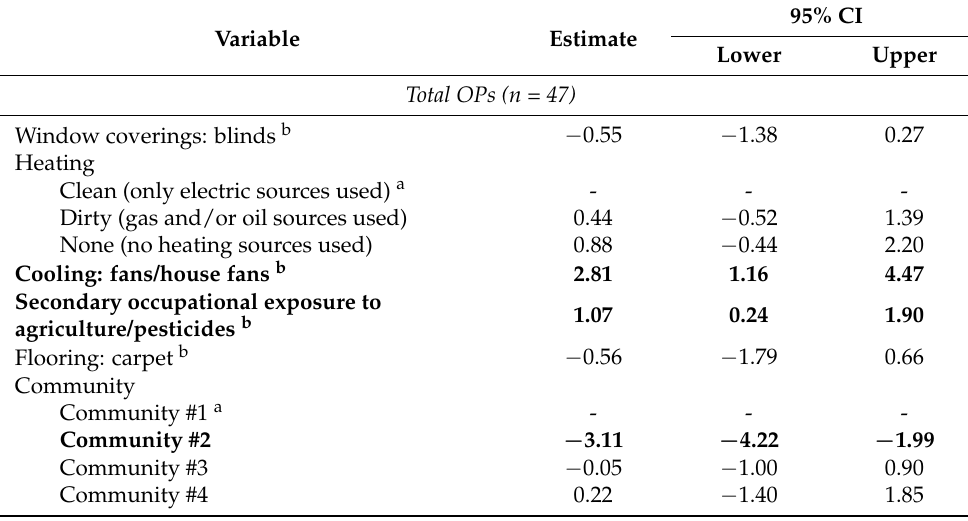
Table 3. Final household dust